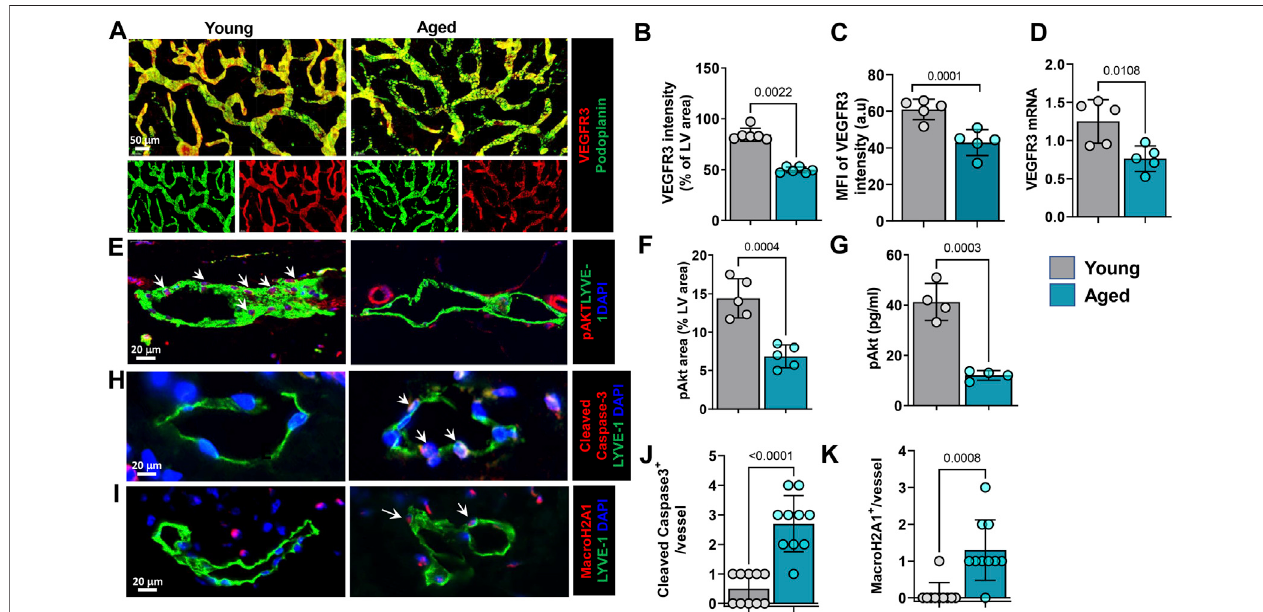
FIGURE 4 | Aging causes decreased LEC VEGFR3 signaling and increased senescence and apoptosis. (A) . Representative confocal images of whole-mounted ear skin stained for podoplanin (PDPN) and VEGFR3. n = 6 mice per group. (B) Quanti fi cation of VEGFR3 immunostaining intensity. (C) Quanti fi cation of VEGFR3 mean fl uorescence intensity (MFI). (D) Quanti fi cation of VEGFR3 mRNA expression in sorted skin LECs measured by qRT-PCR. n = 5 mice per group. (E) Representative confocal images of ear skin sections showing colocalization of lymphatics (LYVE-1) and pAkt. Arrows in young mouse skin indicate strong expression and colocalization of pAkt with LECs. (F) Quanti fi cation of pAkt immunostaining as a percentage of lymphatic vessel area. n = 5 mice per group. (G) ELISA quanti fi cation of pAkt(normalizedtoAkt) from lysates ofsorted skin LECs. n =4miceper group. (H) Representative confocal images ofearskin sections stained forlymphatics (LYVE-1) and apoptosis marker cleaved caspase-3. Arrows highlight cleaved caspase-3 expression in aged mice LECs. (I) Representative confocal images of ear skin sections stained for lymphatics (LYVE-1) and senescence marker MacroH2A1. Arrows highlight MacroH2A1 expression in aged mice LECs. (J,K) Quanti fi cation of cleaved caspase-3+ (J) and MacroH2A1+ (K) LECs on immunostaining. n = 5 mice per group. All quanti fi cations are mean ± SD, unpaired Student ’ s t test.